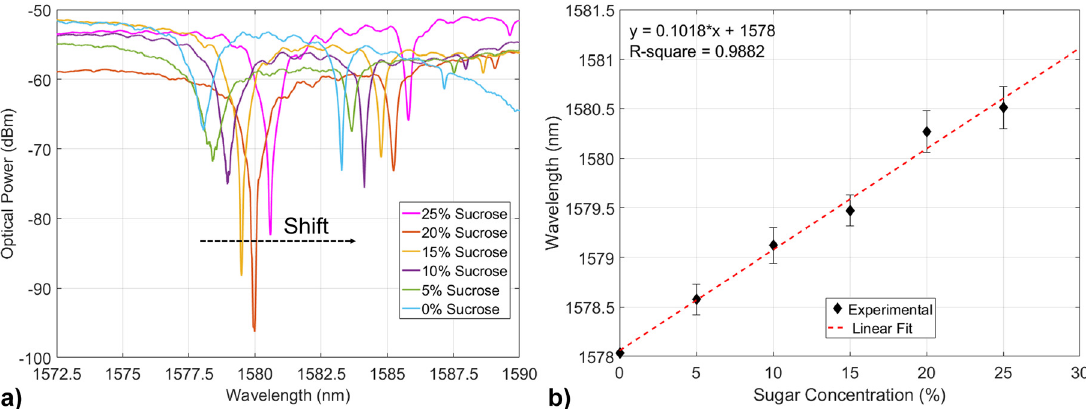
Figure 9: PhC cavity wavelength shift with solution, (a) Measured optical spectrum of the microcavity for different sugar concentrations (from 0% to 5, 10, 15, 20 and 25%) and (b) plot of the microcavity resonance wavelength against sugar concentration, in which the red-dashed line represents a linear fitting of the datapoints. The standard deviations related to these measurements are shown in Figure S.14 of the Supplementary Materials.